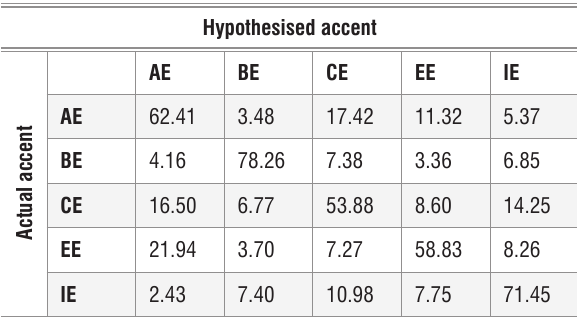
Confusion matrix for the parallel per-utterance accent identification system using multi-accent acoustic models. Confusions are indicated as percentages (%).